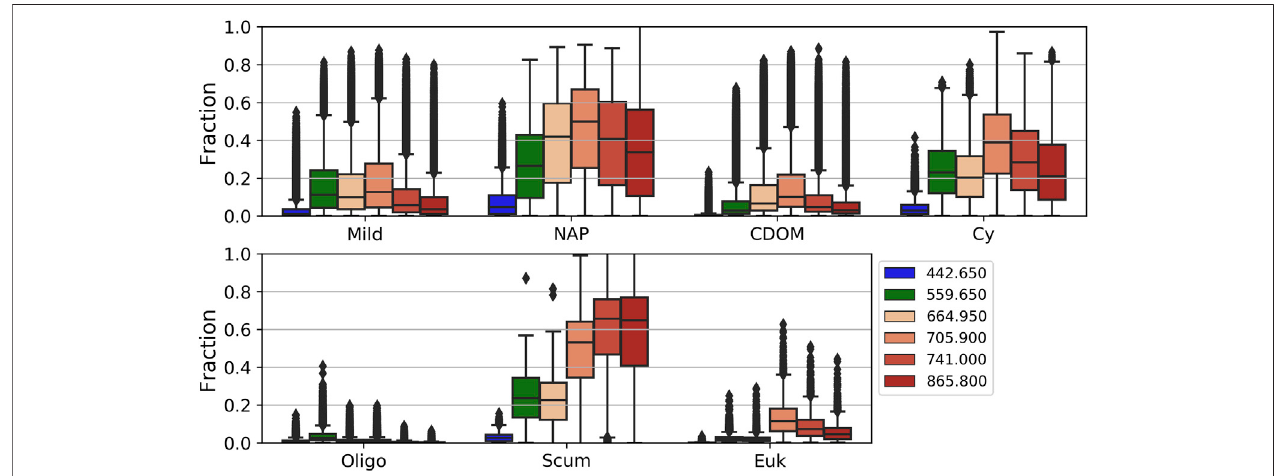
FIGURE 5 | Fraction of surviving L w at L tot for speci fi c wavelengths for each derived OWT.